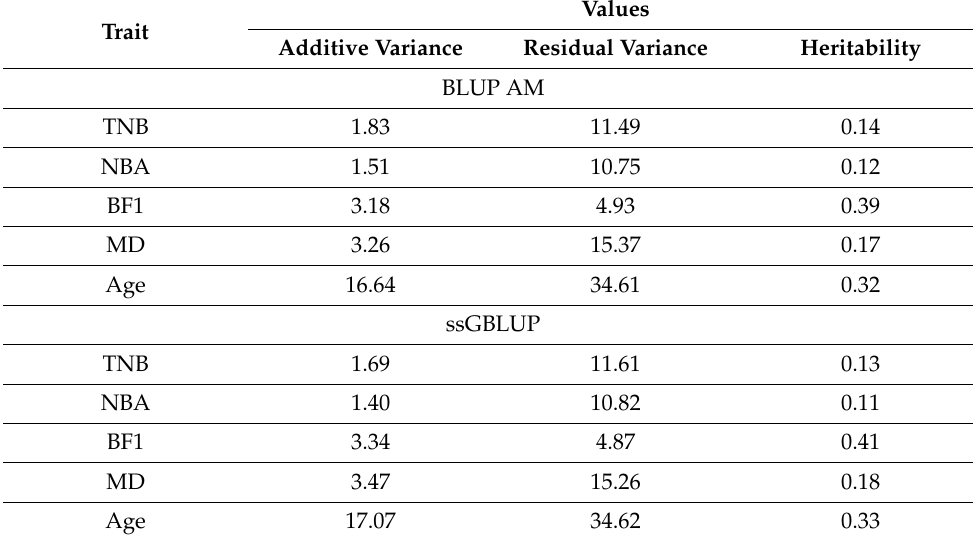
Table 3. Components of variance without and with genomic information. Values Trait Additive Variance Residual